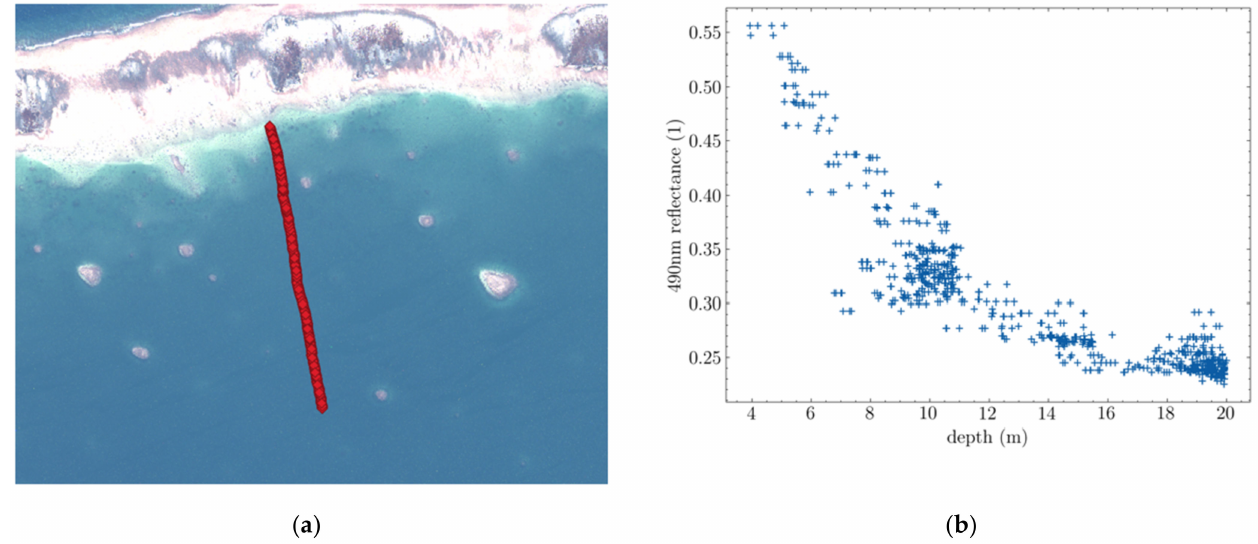
Figure 13. Ground truth provided by a single sounding line in Tahanea. ( a ) World View image and supporting ENC cross-section in red. ( b ) Scatter plot of blue Depth/Reflectance